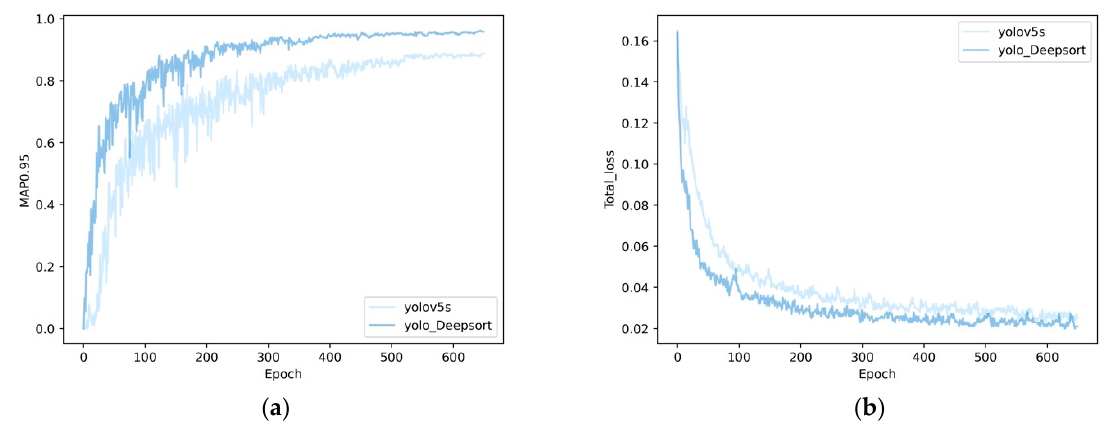
Figure 13. ( a ) The average mean precision of YOLOv5 s and YOLO-deepsort on the train set; ( b ) the total loss curve of YOLOv5 s and YOLO-deepsort on the train